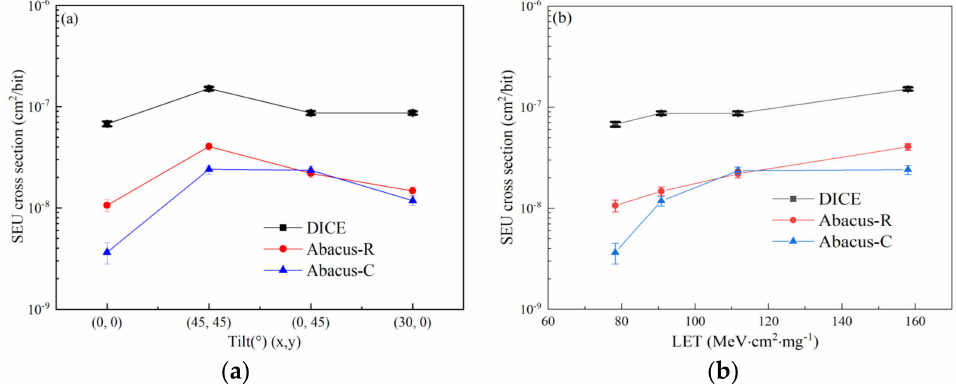
Figure 11. SEU cross section results for full “1” data under ( a ) different irradiation tilts, and ( b ) different LET